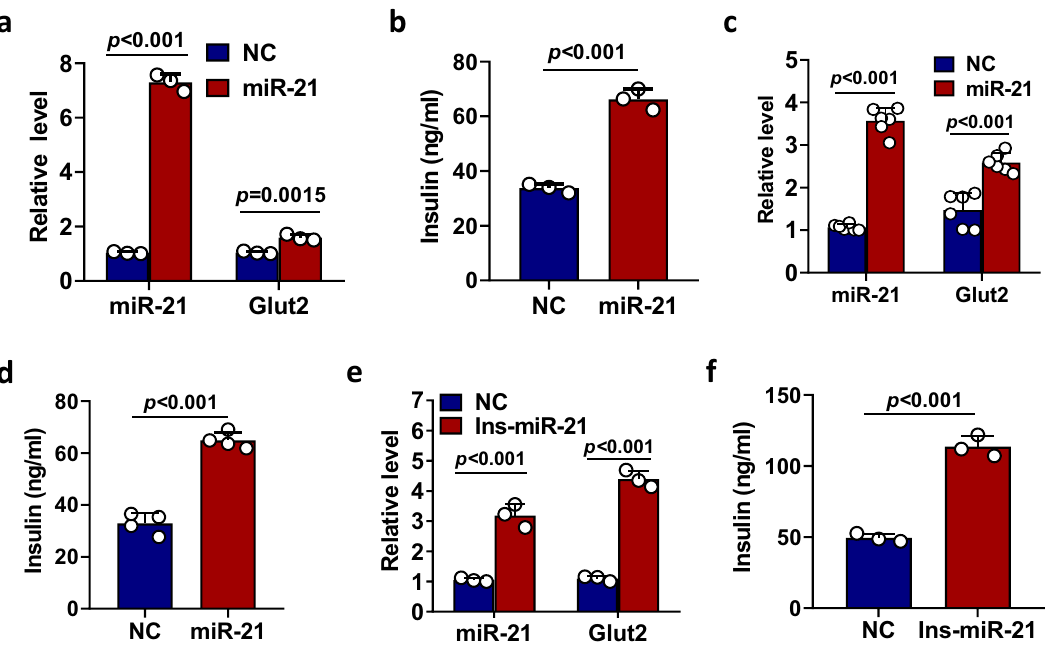
Fig. 7 Increased expression of miR-21 in pancreatic islets promotes Glut2 expression and glucose-stimulated insulin secretion. a , b Pancreatic islets were isolated from 7 – 8-week-old C57BL/6 male mice and infected with negative control virus (NC) or adenovirus over-expressing miR-21 (miR-21). Relative expression levels of miR-21 and Glut2 were determined by quantitative RT-PCR ( a ). Alternatively, virus infected islets were treated with 16.7 mM glucose and insulin level in the culture supernatant was determined by ELISA ( b ). Data are presented as means ± SD for n = 3 biologically independent samples. c , d Pancreatic islets were isolated from healthy donor and infected with negative control virus (NC) or adenovirus over-expressing miR-21 (miR- 21). Expression of human miR-21 and Glut2 ( c ) and the level of glucose-stimulated secretion of insulin ( d ) were determined by quantitative RT-PCR and human insulin ELISA. Data are presented as means ± SD for n = 3 biologically independent samples. e , f Pancreatic islets were isolated from 7 – 8-week-old C57BL/6 male mice and infected with negative control virus (NC) or adenovirus over-expressing miR-21 under the control of mouse insulin promoter (Ins- miR-21). Expression of miR-21 and Glut2 ( e ) and the level of glucose-stimulated secretion of insulin ( f ) were determined by ELISA. Data are presented as means ± SD for n = 3 biologically independent samples. All statistical signi fi cance was analyzed using two-sided unpaired t test and P values are indicated in the fi gure. ns not signi fi cant. Data shown are representative results from at least two independent experiments. Source data are provided as a Source Data fi